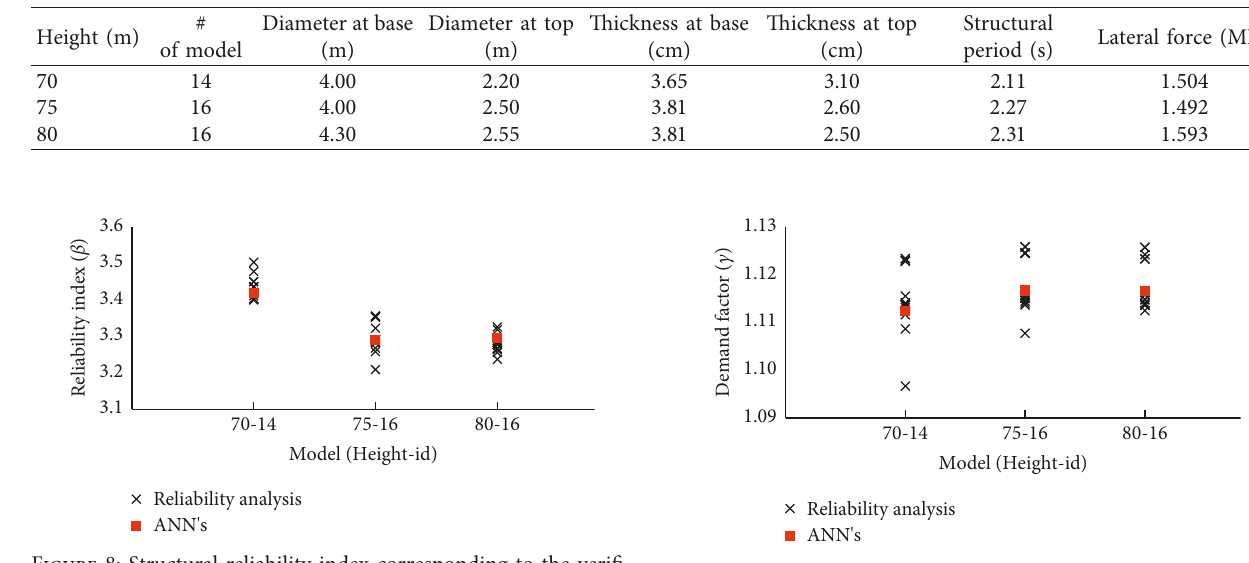
Table 7: Characteristics of the verification models.